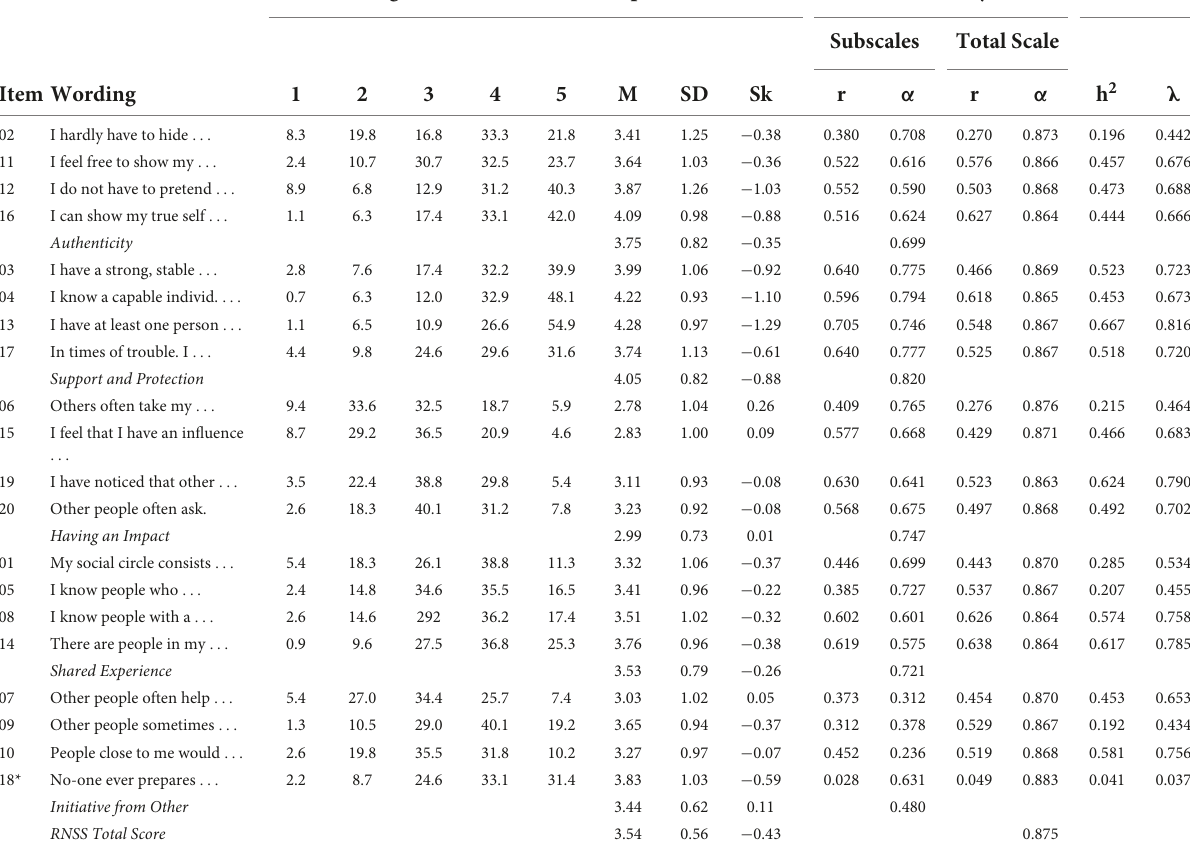
TABLE 2 Descriptive and psychometric characteristics of RNSS ( n = 459). Percentage distribution and descriptive